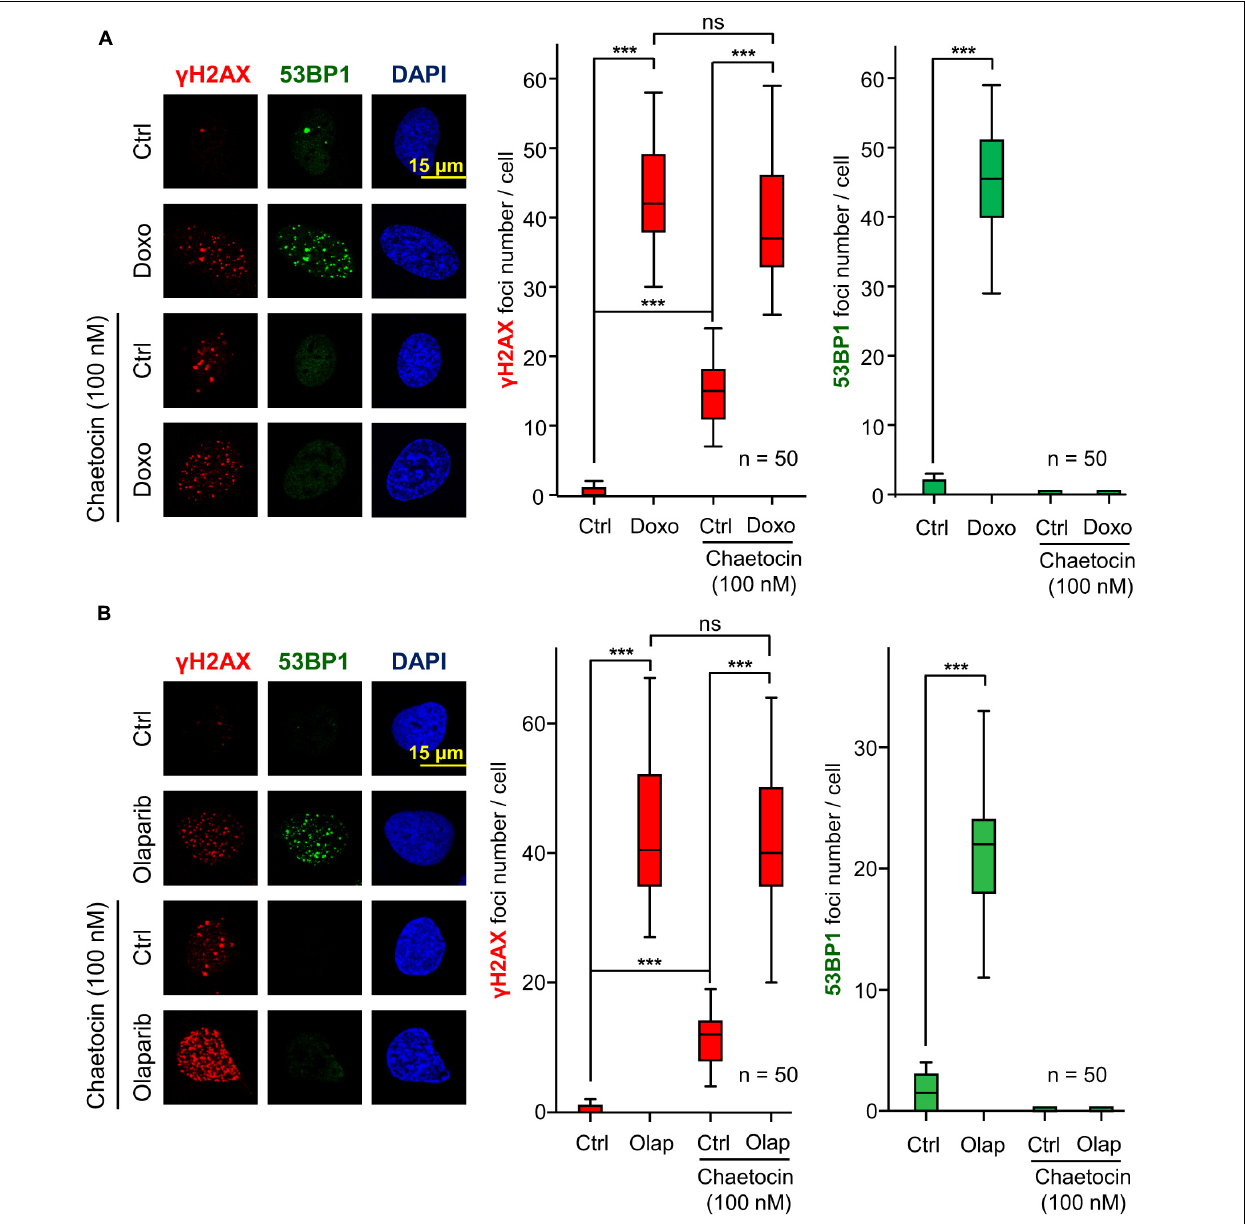
FIGURE 2 | Effect of chaetocin on the formation of γ H2AX and 53BP1 foci after inducing DSBs with doxorubicin (Doxo) (A) and olaparib (Olap) (B) in U2OS cells deprived of serum mitogenic signals. The effect of chaetocin on these foci in response to IR in SK-LMS-1 cells is shown in Supplementary Figure 2 . Quantifications of these nuclear foci in response to chaetocin and/or doxorubicin or olaparib are shown to the right. ns, not significant, *** p < 0.001. These images only show the detail in one cell selected for presentation. The field images are shown in Supplementary Figure 3 . Ctrl, control without doxorubicin or olaparib, as appropriate.